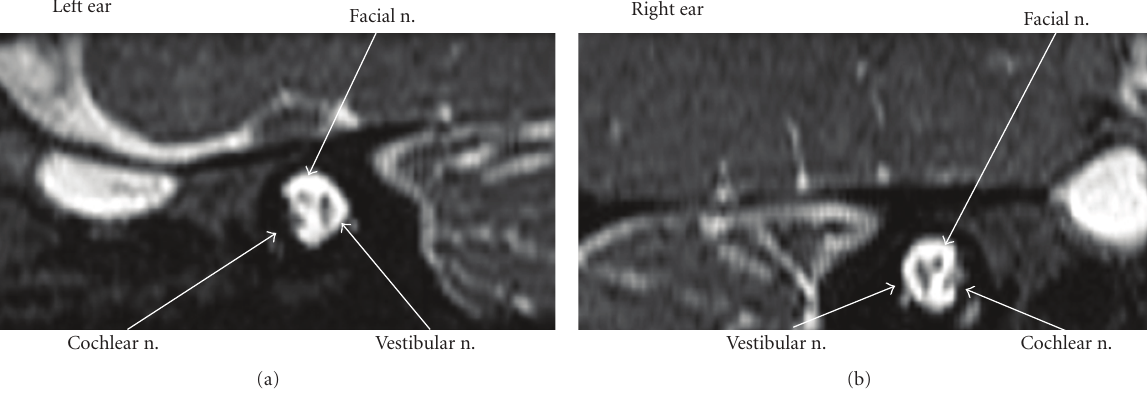
Figure 2: The images of normal cochlear nerve in a patient with unilateral profound sensorineural hearing